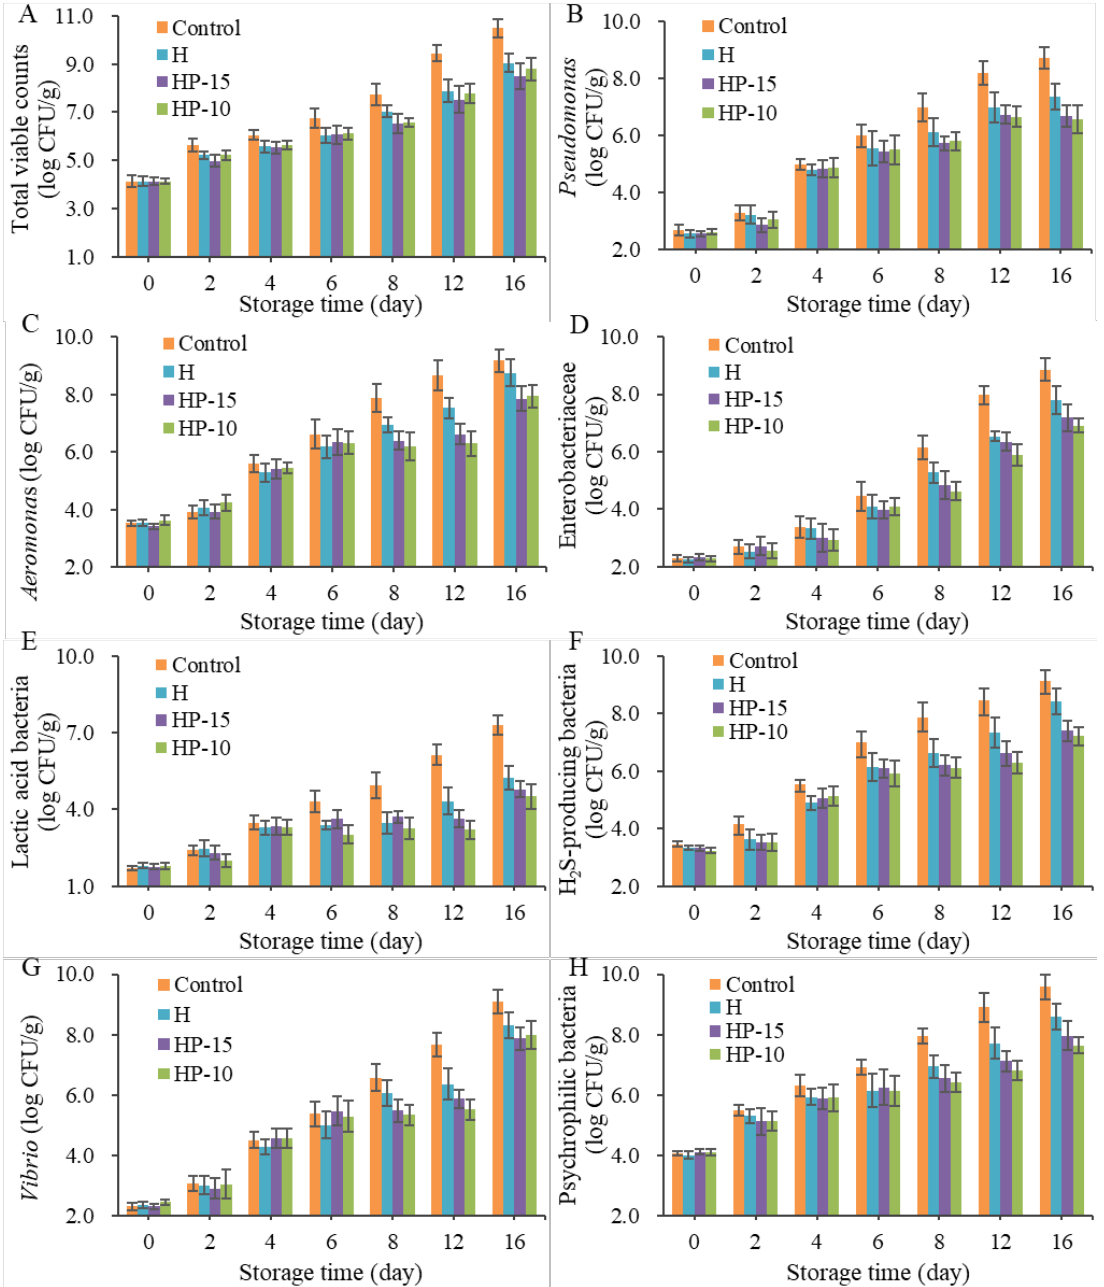
Figure 4. Changes in microbes of sturgeon fillets during refrigerated storage (4 °C). (A) Total viable counts, (B) number of Pseudomonas , (C) number of Aeromonas , (D) number of Enterobacteriaceae, (E) number of Lactic acid bacteria, (F) number of H 2 S-producing bacteria, (G) number of Vibrio , (H) number of Psychrophilic bacteria (CK: control; H: 2% sodium alginate + antibacterial agents; HP-10: 2% sodium alginate + antibacterial agents + 1:10 protein solution; HP-15: 2% sodium alginate + antibacterial agents + 1:15 protein solution).